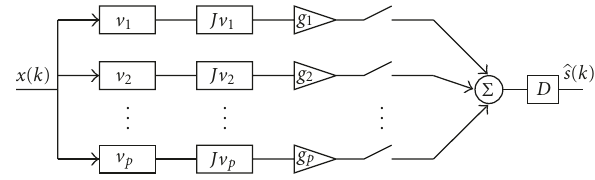
Figure 1: FIR-filter implementation of subspace-based speech en- hancement. Each singular triplet corresponds to a zero-phase fil- tered version of the noisy